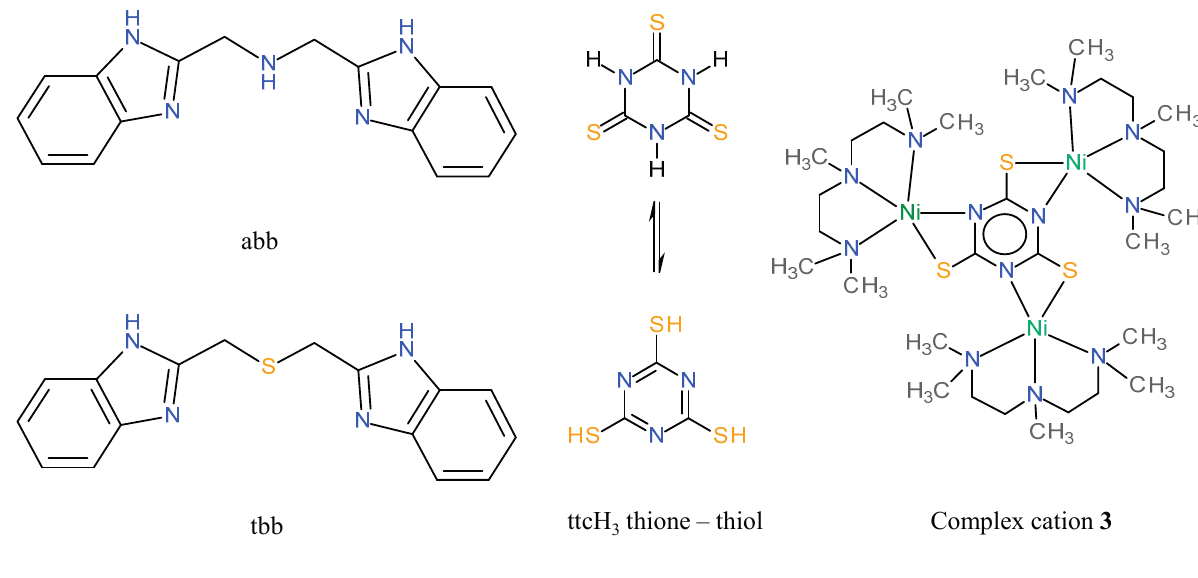
tbb ttcH 3 thione – thiol Complex cation Figure 1. Structural formulas of the ligands used and the complex cation [Ni 3 (pmdien) 3 ( μ -ttc)](ClO 4 ) 3 ( 3 ). abb = 1-(1 H -benzimidazol-2-yl)- N -(1 H -benzimidazol-2- ylmethyl)methanamine, tbb = 2-(1 H -benzimidazol-2-ylmethylsulfanyl-methyl)-1 H - benzimidazole, ttc H 3 = trithiocyanuric acid in its thione and thiol forms.